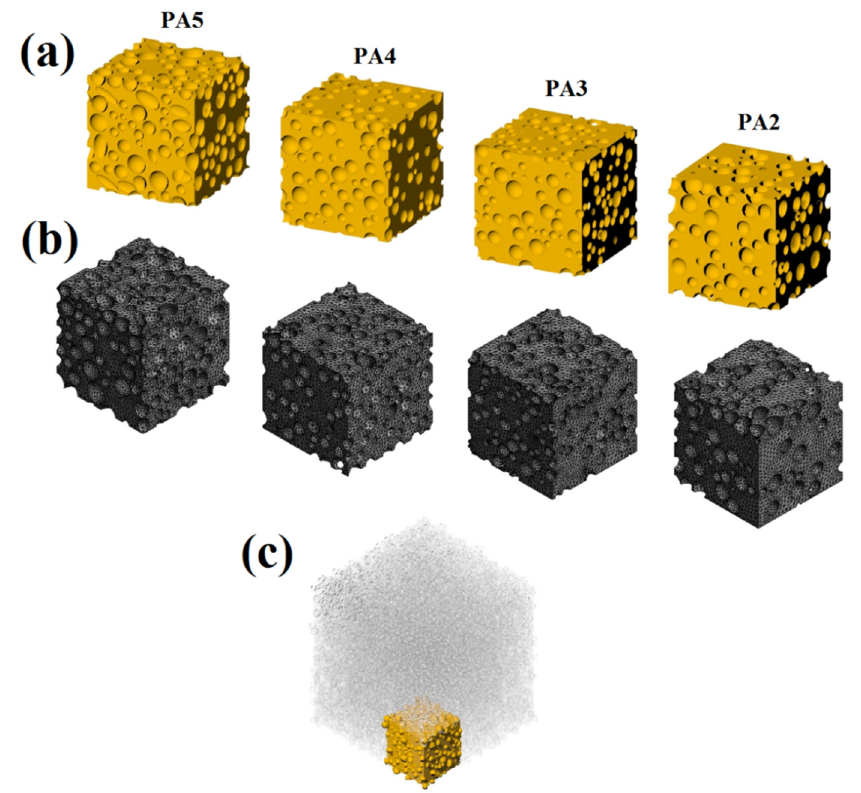
Figure 6. ( a ) Final 3D geometric models, ( b ) meshed geometric model and ( c ) the RVE used.